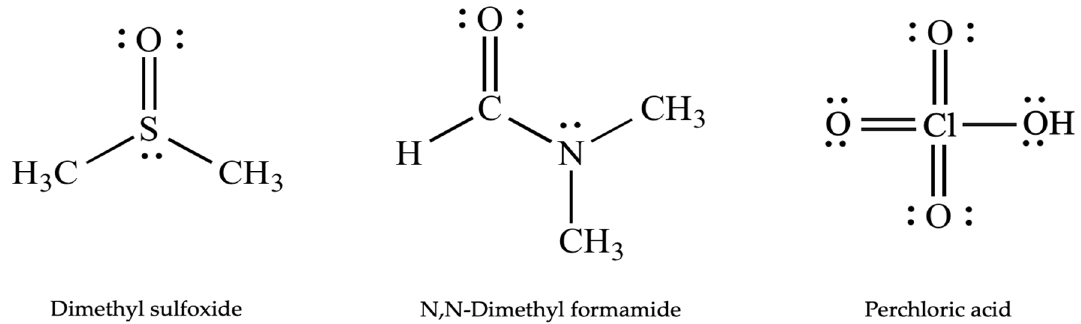
Figure 1. Lewis structure of the solvents used as liquid medium in the exfoliation of graphite.